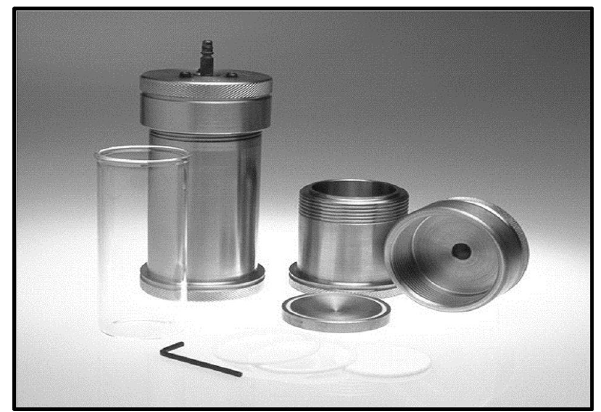
Fig. 1 Aged cell and accessories (Fann Instrument Company 2005)